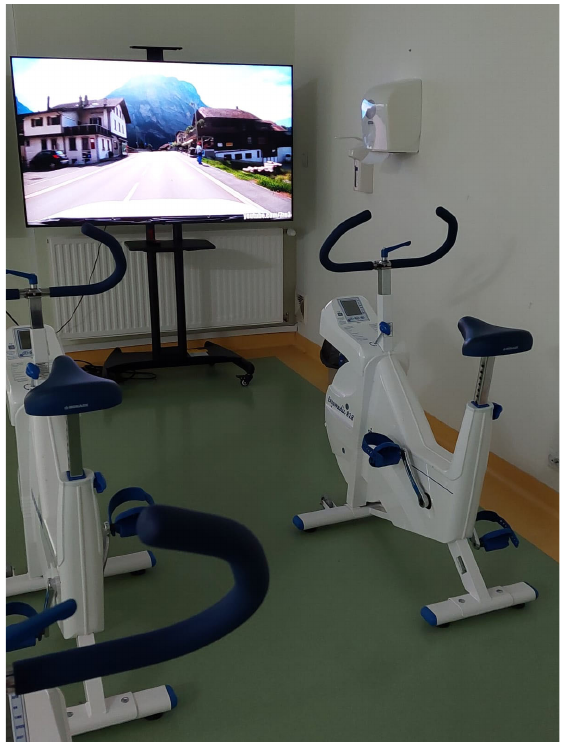
Figure 1. Station for capacity training on a cycle ergometer.